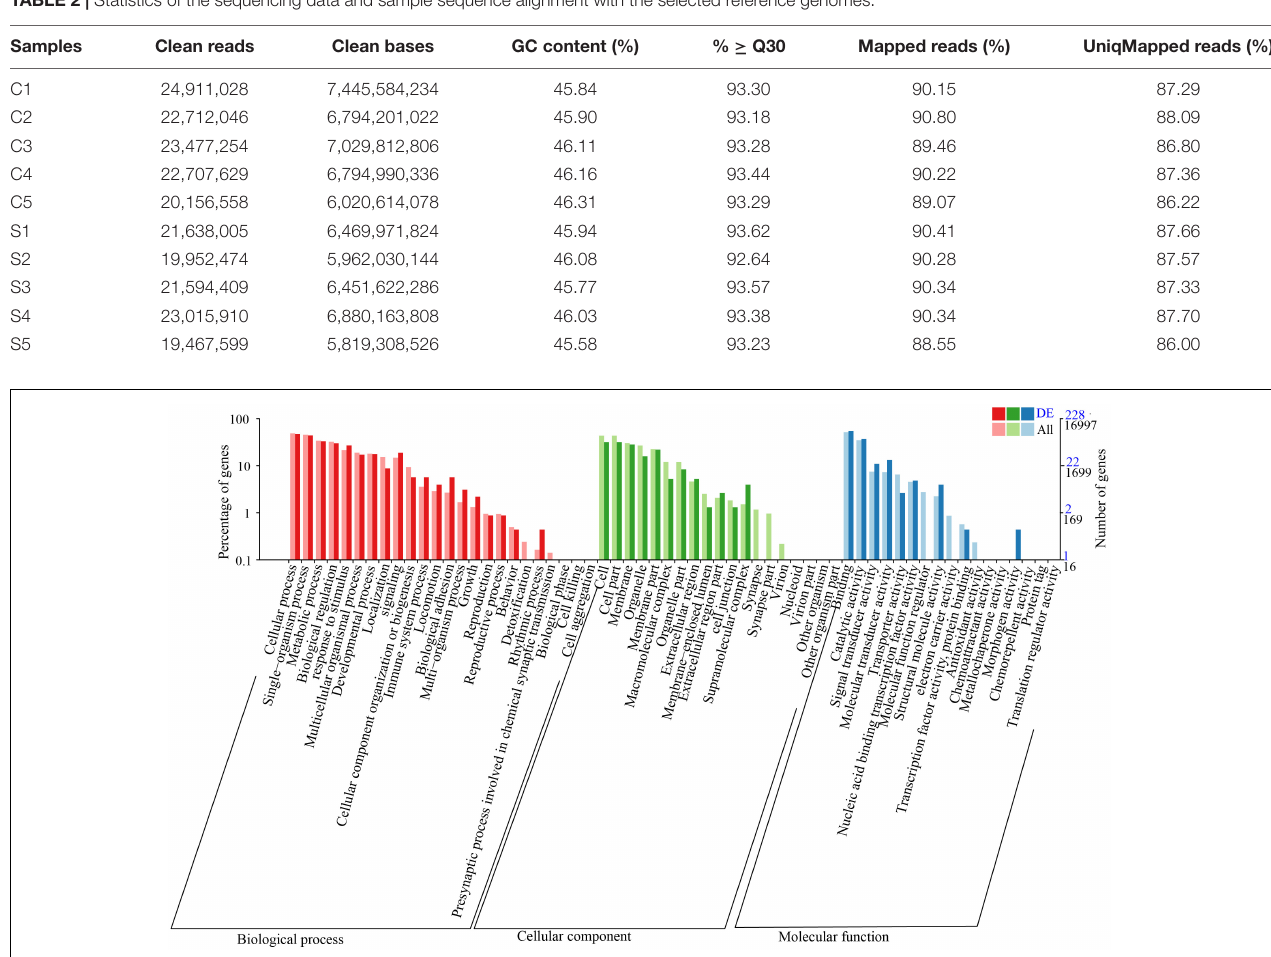
FIGURE 1 | Gene ontology (GO) analysis of all genes and differentially expressed genes (DEGs).